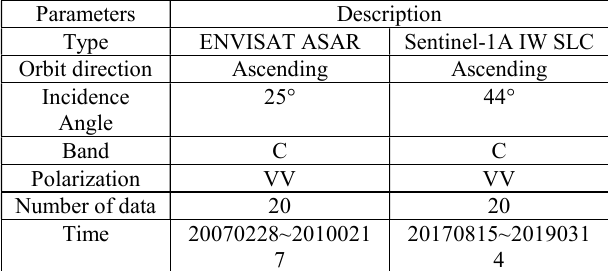
Figure 1. Overview of Shenzhen reclamation area Table 1. Basic parameters of the satellite